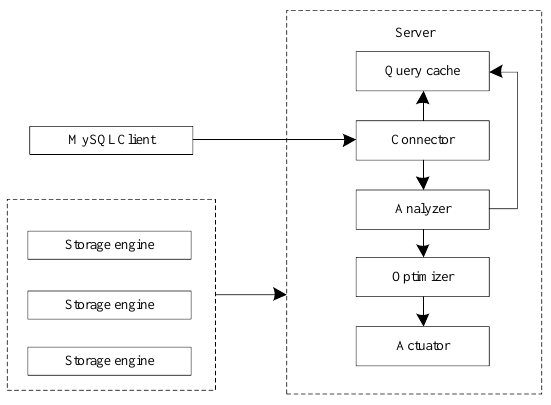
Figure 3. MySQL database structure